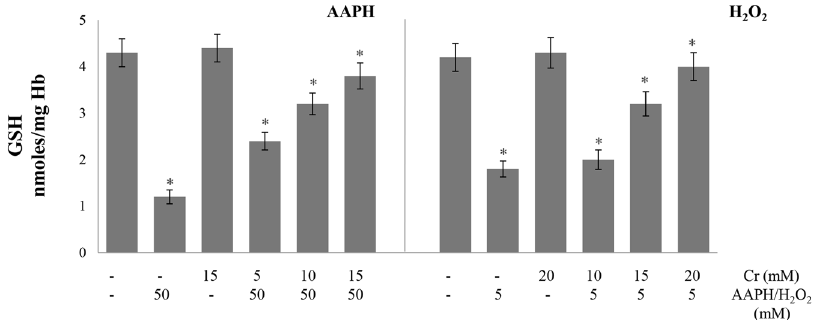
Fig 4. Effect of creatine on AAPH/ H 2 O 2 -induced changes in glutathione levels. Erythrocytes were treated with the indicated concentrations of H 2 O 2 /AAPH, in presence and absence of Cr. Reduced glutathione (GSH) levels were determined in hemolysates. Results are mean values ± SEM from six independent experiments using blood from different donors. * Significantly different from control (p < 0.05).